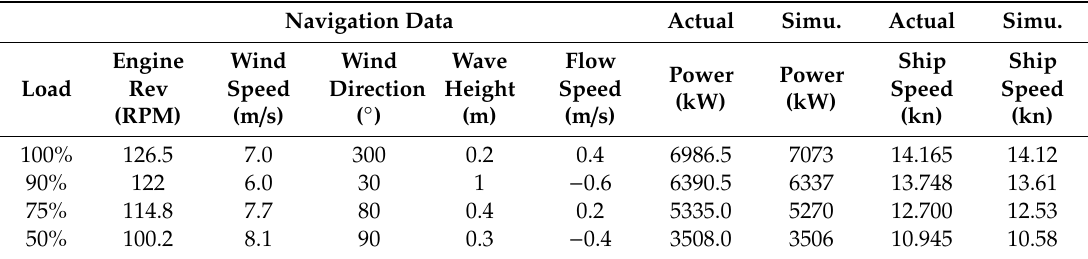
Table 3. Comparison between the simulation model and real ship